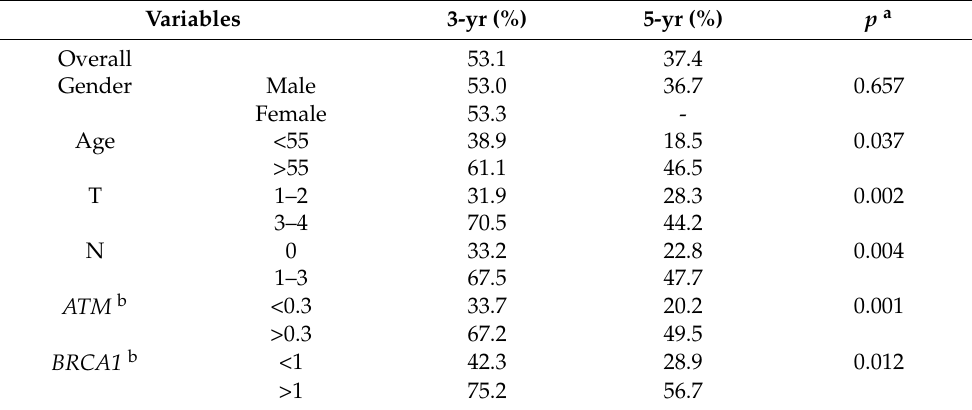
Table 3. Kaplan-Meier analysis of overall survival rates.